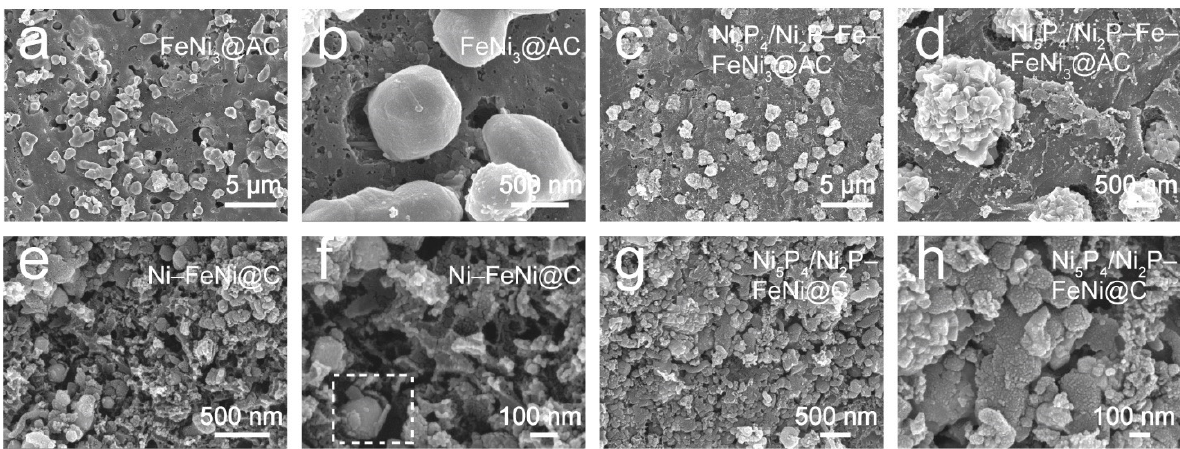
Figure 3. The morphology of the as-prepared samples. SEM images of FeNi 3 @AC ( a , b ), Ni 5 P 4 /Ni 2 P– Fe–FeNi 3 @AC ( c , d ), Ni–FeNi@C ( e , f ) and Ni 5 P 4 /Ni 2 P–FeNi@C ( g , h ) samples at different magnifica-